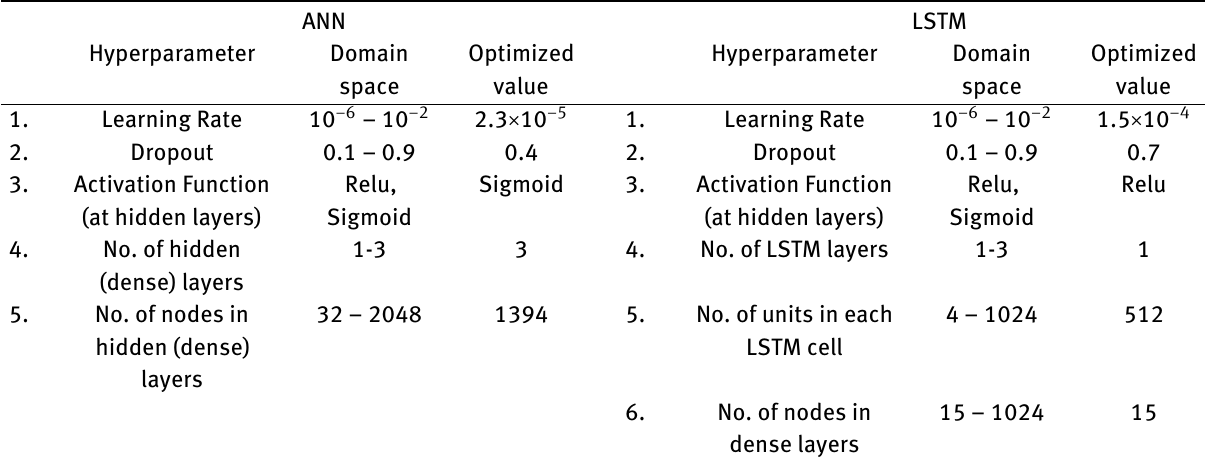
Table 1: Table showing domain space and optimized values for ANN and LSTM classification